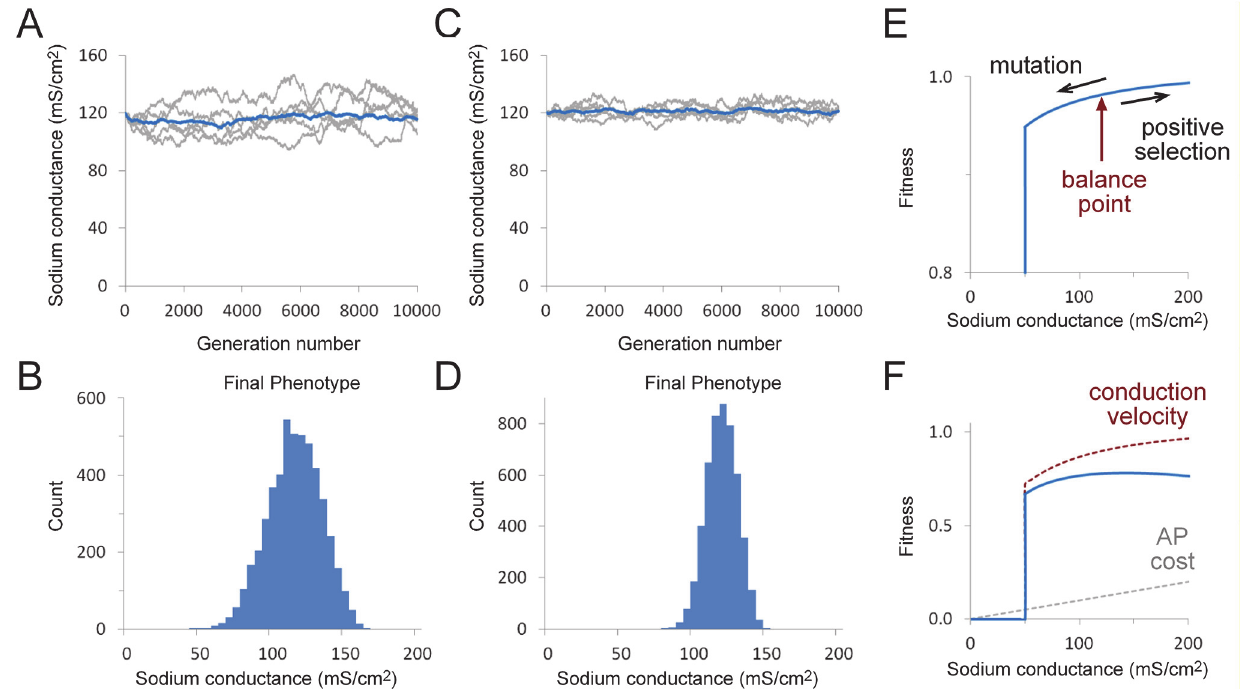
Fig 6. Effect of different selection criteria on sodium channel expression over successive generations. A. Evolution of average sodium conductance phenotype under selection for conduction velocity over time (10000 generations, population = 5000). The blue line is the average value of ten simulation runs and five independent runs are shown in light grey on the same graph. The average final conductance value was 116 ± 9 mS/cm 2 (mean ± S.D., n = 10). B. Histogram of representative final phenotype distribution for a single simulation run. C. Evolution of average sodium conductance phenotype under selection for both conduction velocity and sodium conductance cost over time (10000 generations, population = 5000). The blue line is the average value of ten simulation runs and five independent runs are shown in light grey on the same graph. The average final conductance value was 120 ± 3.5 mS/cm 2 (mean ± S. D., n = 10). D. Histograms of representative phenotype distribution for a single simulation run. E. Fitness function used in (A) and (B). Conduction as a function of sodium conductance (shown in Fig 2A) was scaled and combined with the fitness cliff shown in Fig 4C. Note the magnified scale. F. Fitness function (blue line) used in (C) and (D) was created by subtracting a cost of action potential generation (grey dotted line) from the conduction velocity (red dotted